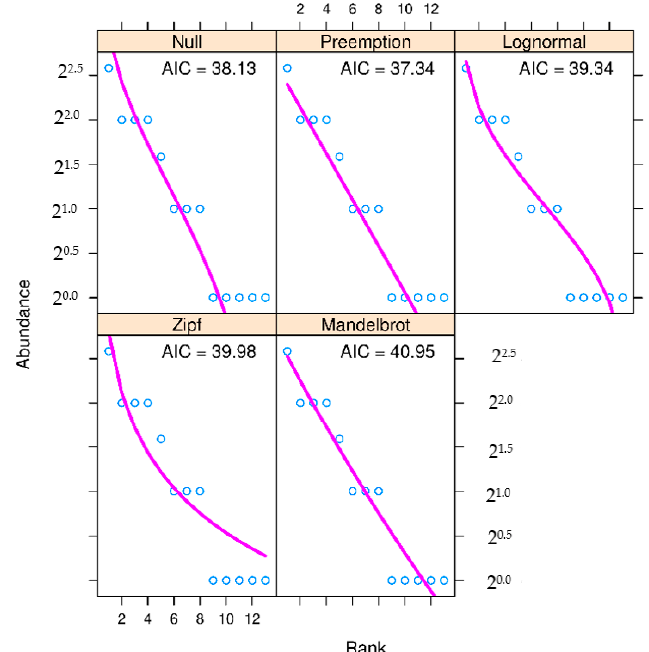
Figure 13. Rank-Abundance Dominance plot for water species with 5 model fits: brokenstick, preemption, log-Normal, Zipf, and Zipf-Mandelbrot. AIC, Akaike information